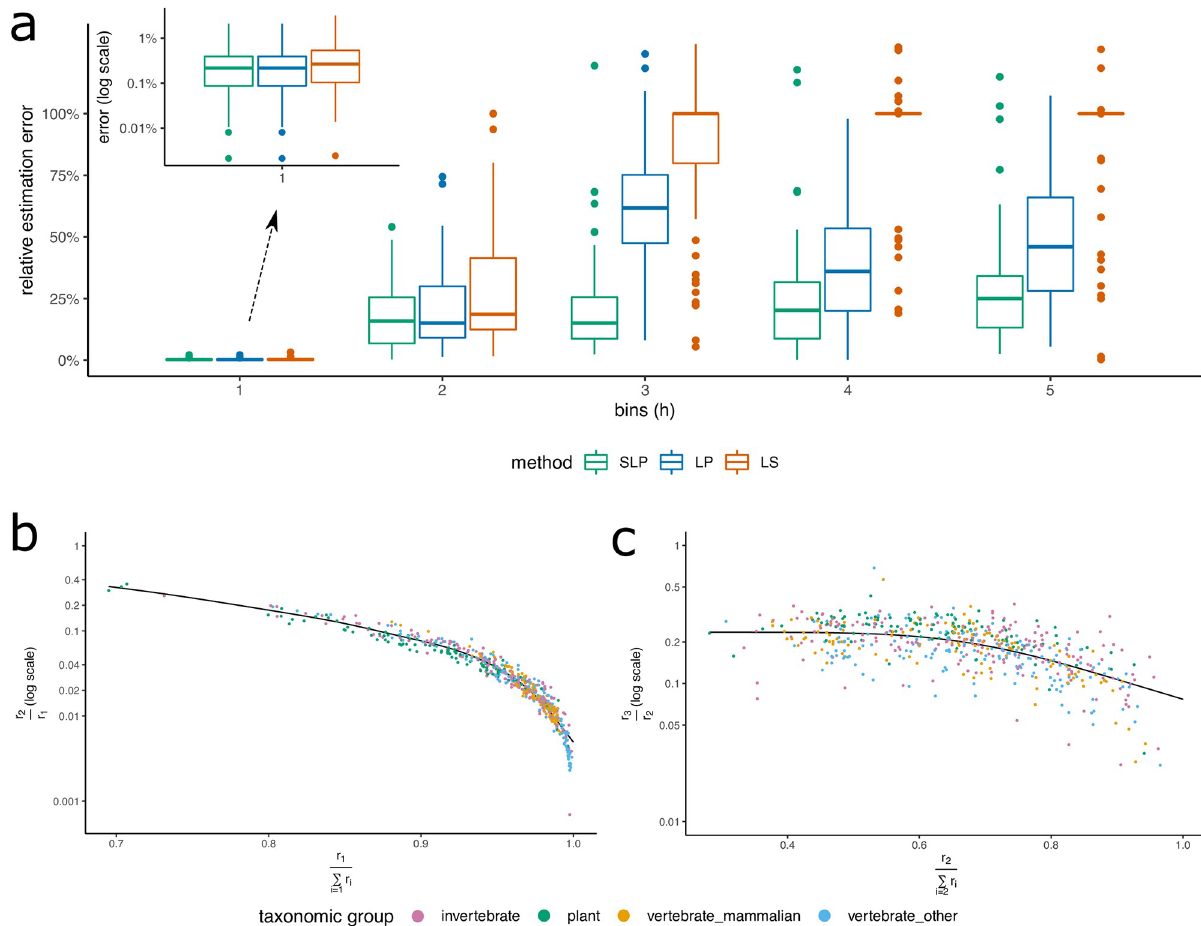
Fig 2. Repeat spectra estimation. A: The relative error in estimating repeat spectra using Least-Squares (LS), constrained Linear Programming (LP), and Spline Linear Programming (SLP). The genome-skims are simulated at 1X with no sequencing error. B: Correlation between true r 2 / r 1 ratios, and our estimates of r 1 / ∑ for each genome. C: Similar correlation plot between true r 3 / r 2 and estimated r 2 / ∑ i =1 r i Y axis are computed from the assemblies, and the estimated indices on X axis are obtained by applying the LP method to the simulated skims described in